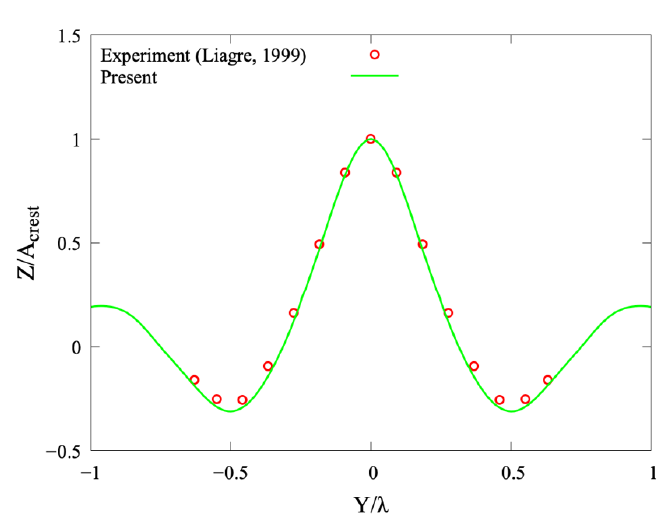
Figure 9. Simulated rogue wave profile at x = 0 plane.